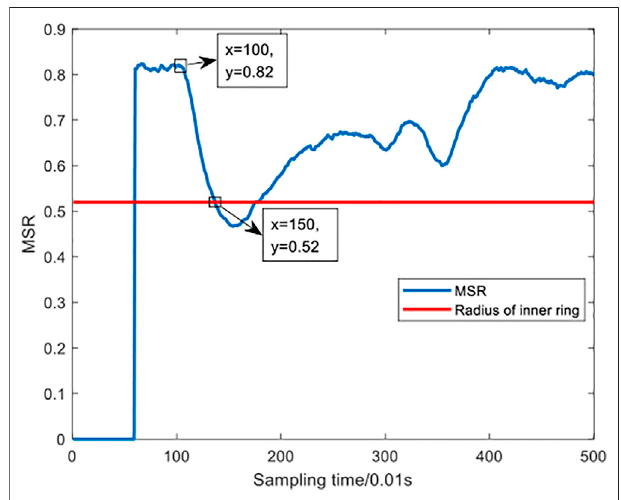
FIGURE 4 | MSR index of case 1.